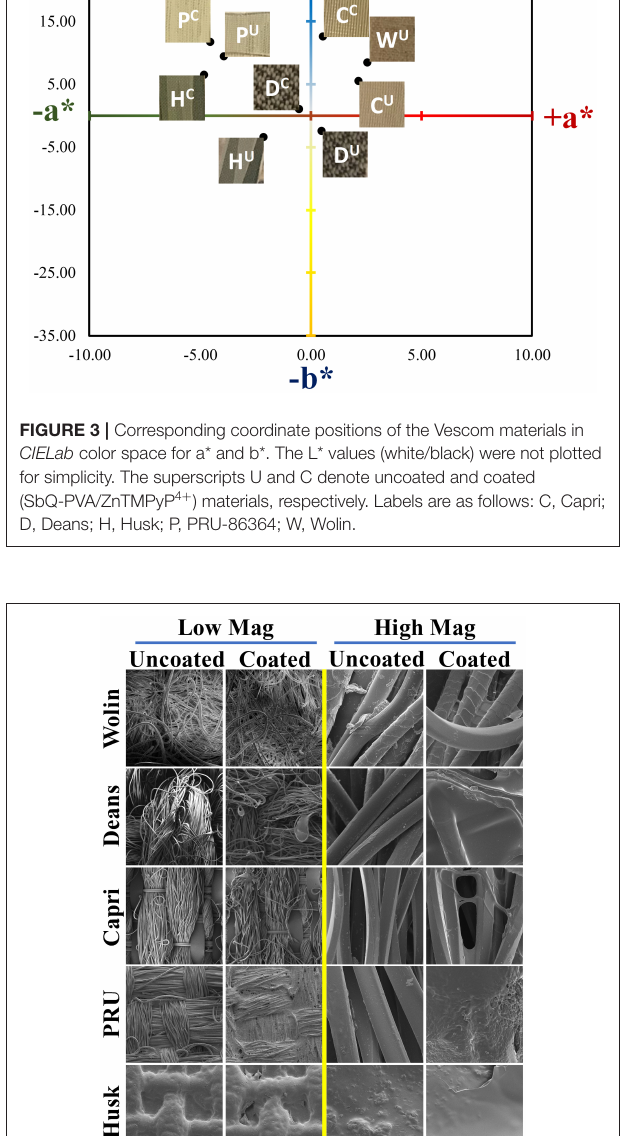
the uncoated materials. The concentration of the ZnTMPyP 4 + PS varied ∼ nine-fold across all materials as follows: Husk (0.78